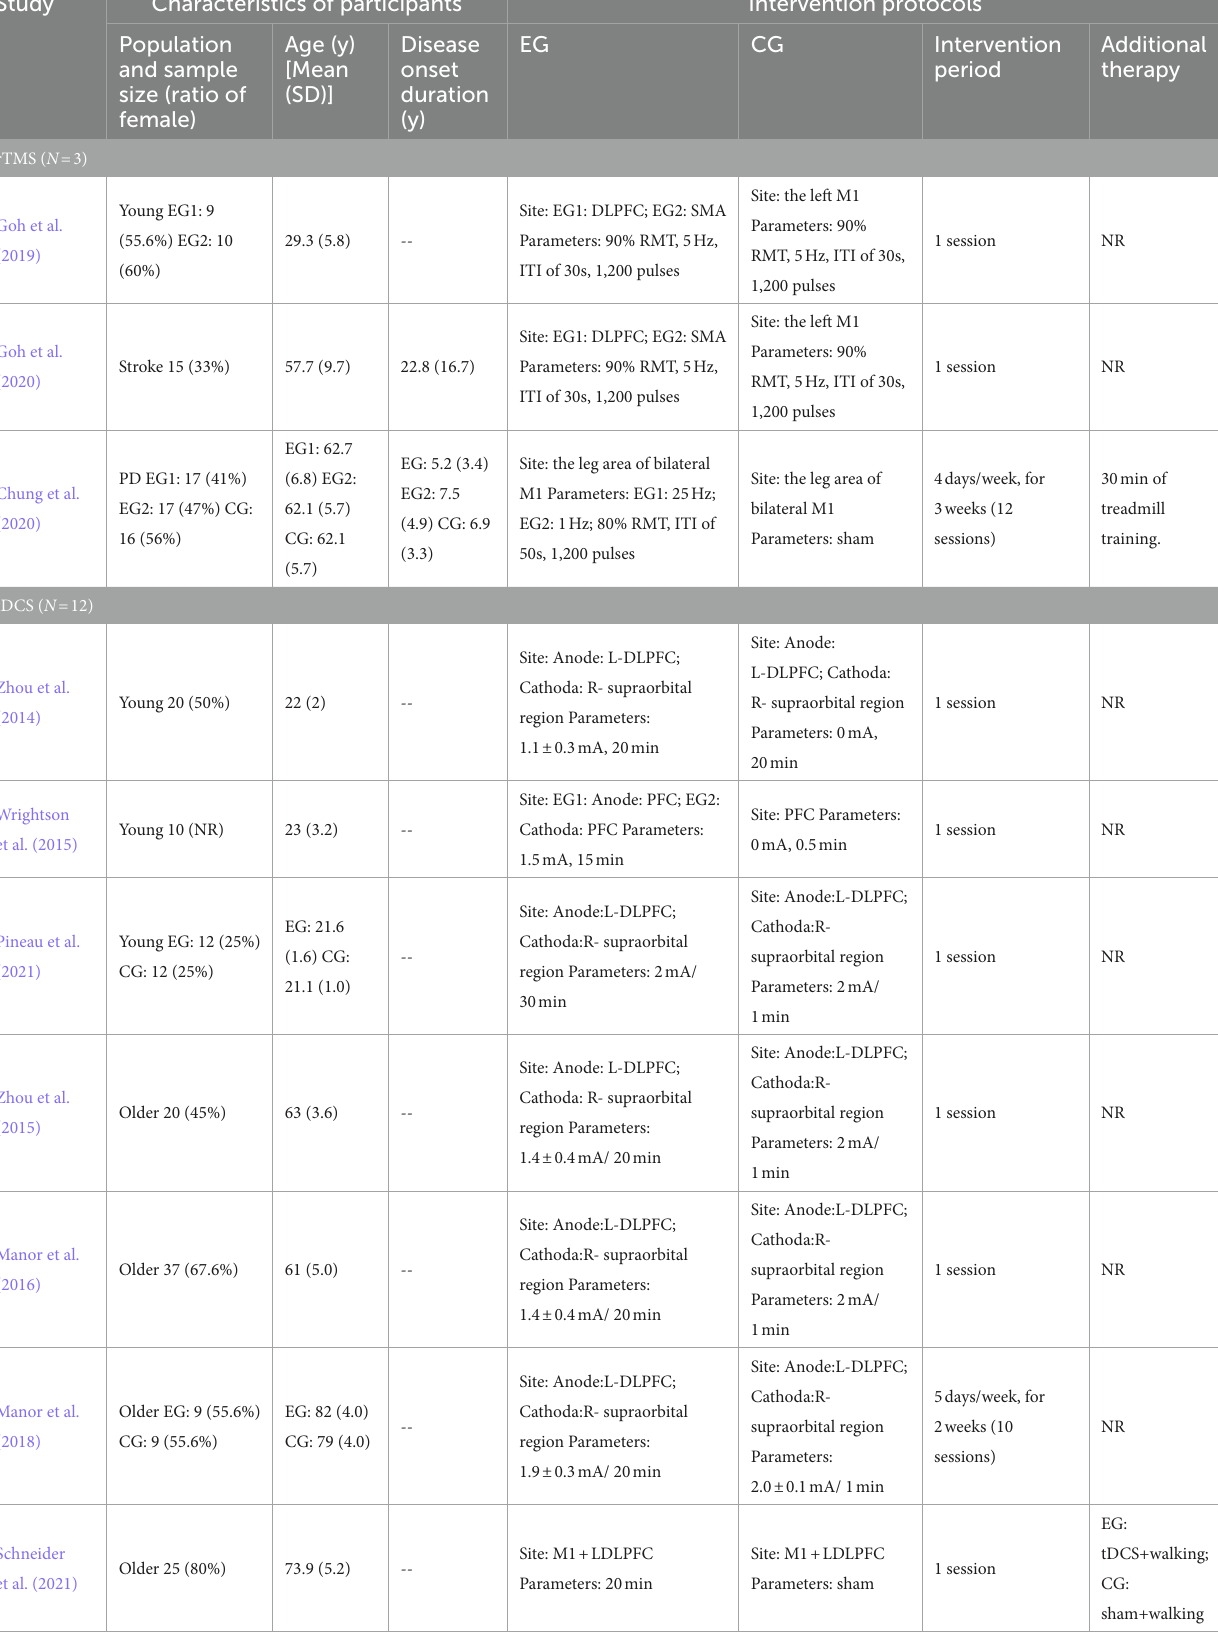
TABLE 2 Characteristics of participants and intervention protocols. Study Characteristics of participants Intervention protocols Population and sample